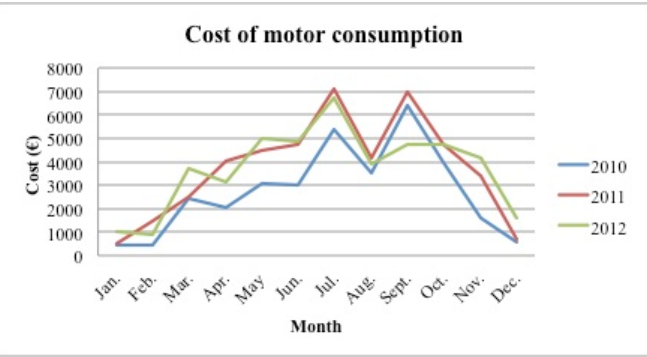
Figure 8. Costs of motor power consumption—monthly data.